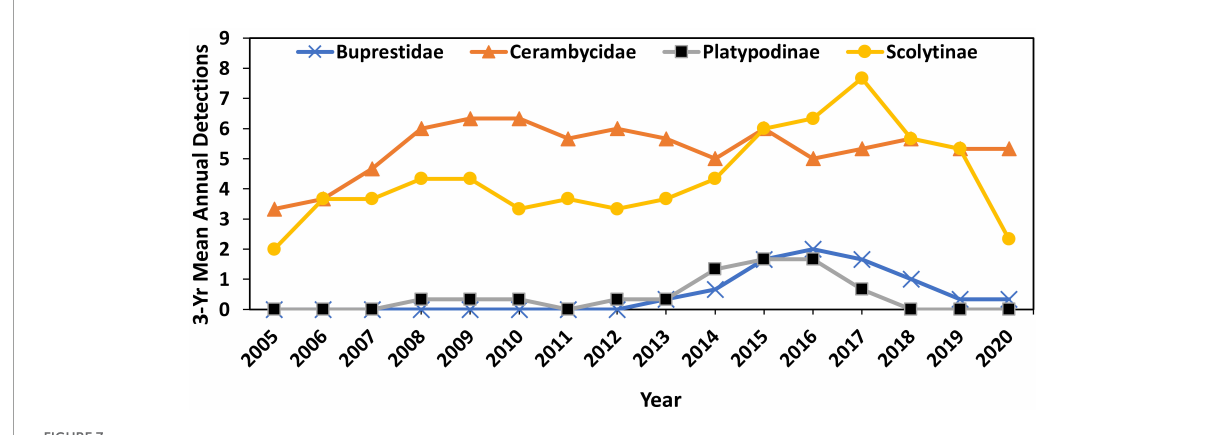
FIGURE7 Three-year running averages for the four main groups of wood borers intercepted in WPM during 2003–2020 based on the final dataset for AQIM records from 2003 to 2020.